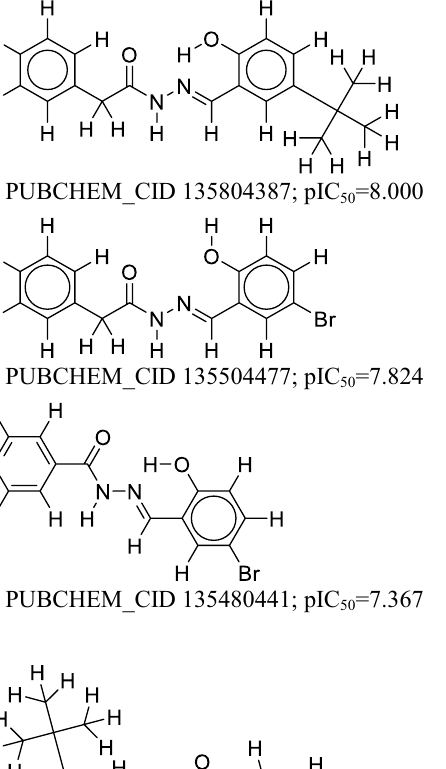
of salicylidene acylhydrazides 50